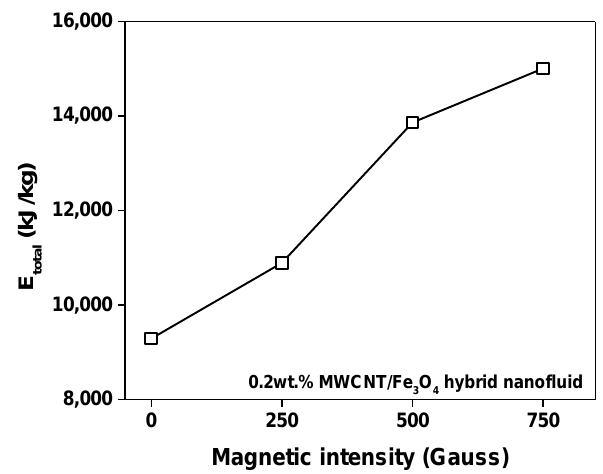
Figure 17. Total stored energy in a 0.2 wt% MWCNT / Fe 3 O 4 hybrid nanofluid during heating under different magnetic intensities [41]; 2020, Elsevier.